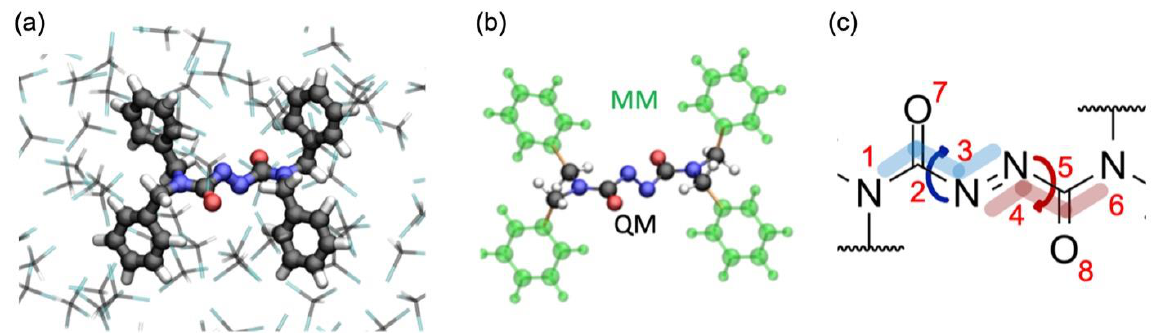
Figure 1. ( a ) QM/MM set up of the system (balls and sticks representation) in a chloroform solvent (stick representation). ( b ) Partitioning scheme of the solute; the QM region contains the azodicar- boxamide unit, while the MM region contains the phenyl rings; bonds across which the QM/MM cut is applied are highlighted in orange. ( c ) Lewis structure of the photo-active azodicarboxamide unit with atom labeling; note that the GS geometry is not planar, showing a 75° distortion of the N 1 -C 2 -N 3 -N 4 and N 3 -N 4 -C 5- N 6 dihedrals.